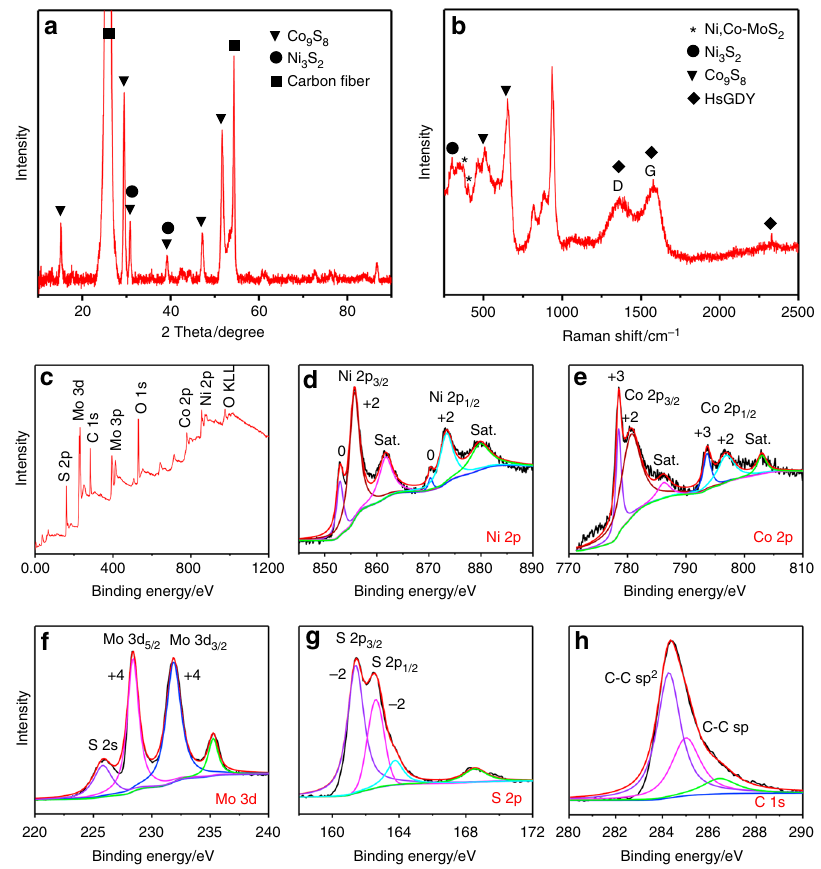
Fig. 5 Component characterizations of the tri-layered nanoarrays. a X-ray diffraction (XRD) pattern, b Raman spectrum, c X-ray photoelectron spectroscopy (XPS) survey spectrum, and d – h high-resolution XPS spectra of Ni, Co, Mo, S, and C for the triple-layered NiCoS@HsGDY@Ni,Co-MoS 2 nanotubes comprised of Ni 3 S 2 /Co 9 S 8 inner layer (NiCoS), hydrogen-substituted graphdiyne (HsGDY), and Ni-,Co-co-doped MoS 2 (Ni,Co-MoS 2